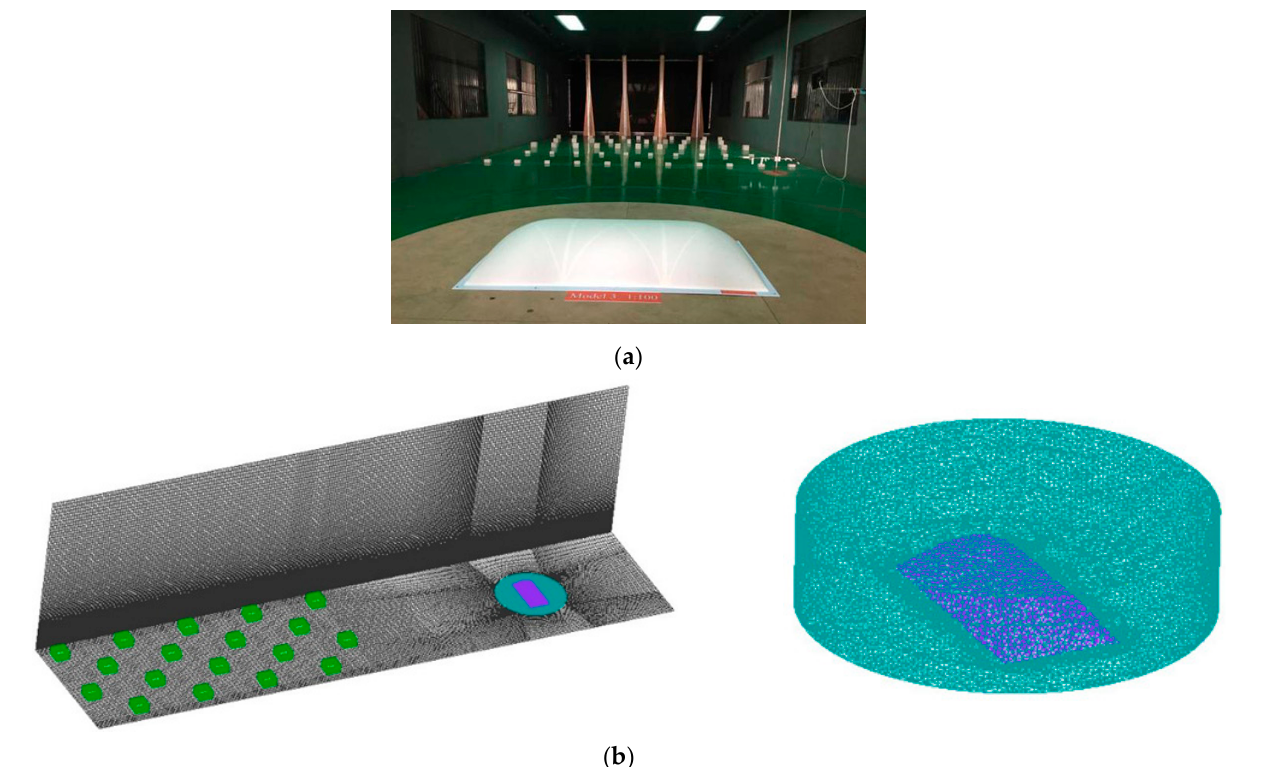
Figure 12. Models in the wind tunnel test and numerical simulation: ( a ) Wind tunnel test model; ( b ) Numerical simulation model.